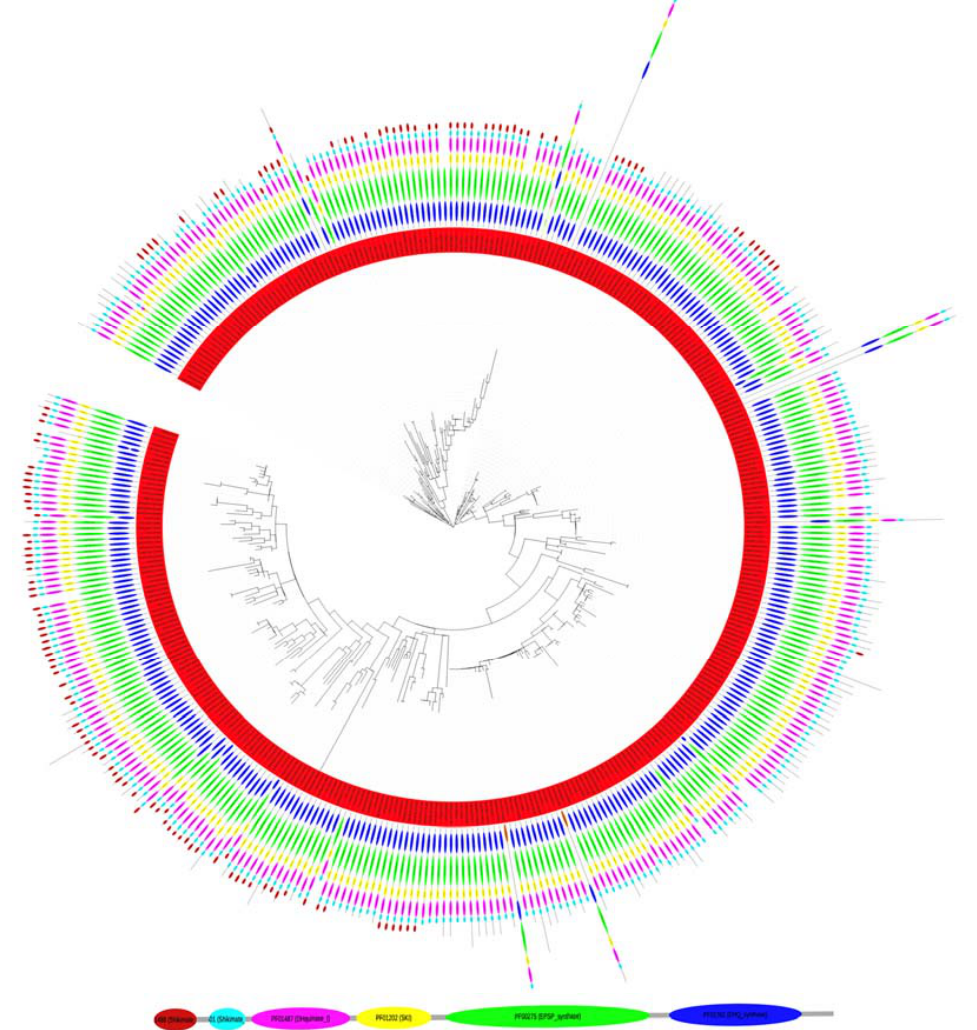
Figure 3. Phylogenetic conservation of the multi-domain structure of the EPSPS protein in 390 fungi. The ancestral domain structure includes the EPSPS (PF00275; green) and EPSPS-associated domains Shikimate_DH (PF01488l; maroon), Shikimate_dH_N (PF08501; light blue), DHQuinase_I (PF01487; pink), SKI (PF01202, yellow), and 3-dehydroquinate synthase (PF01761; blue). Figure modified from [4] with permission. A detailed view of the phylogenetic tree is freely accessible at